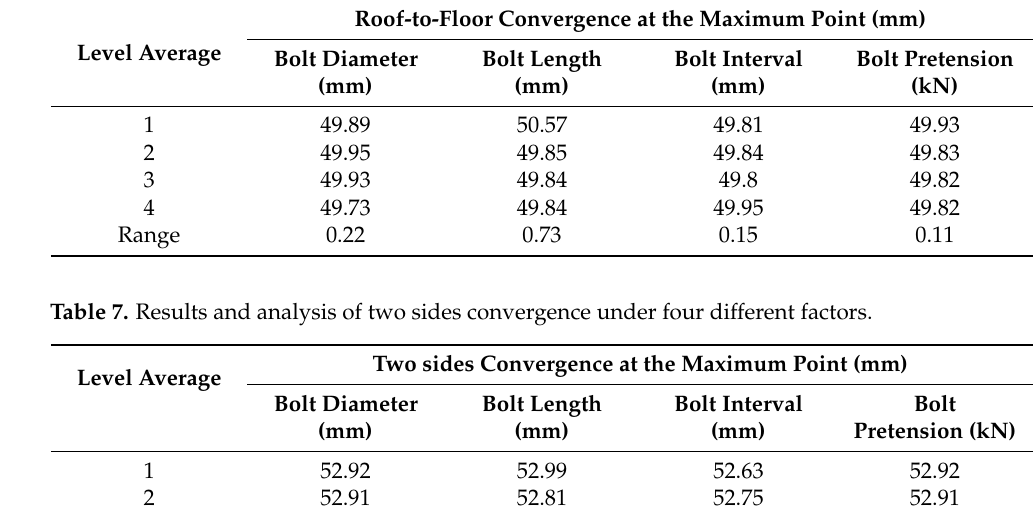
Figure 9. The variation curve of roadway convergence under the different influencing factors. ( a ) Bolt diameter influence; ( b ) Bolt length influence; ( c ) Bolt interval influence; ( d ) Pretension influence. Table 6. Results and analysis of roof-to-floor convergence under four different factors.